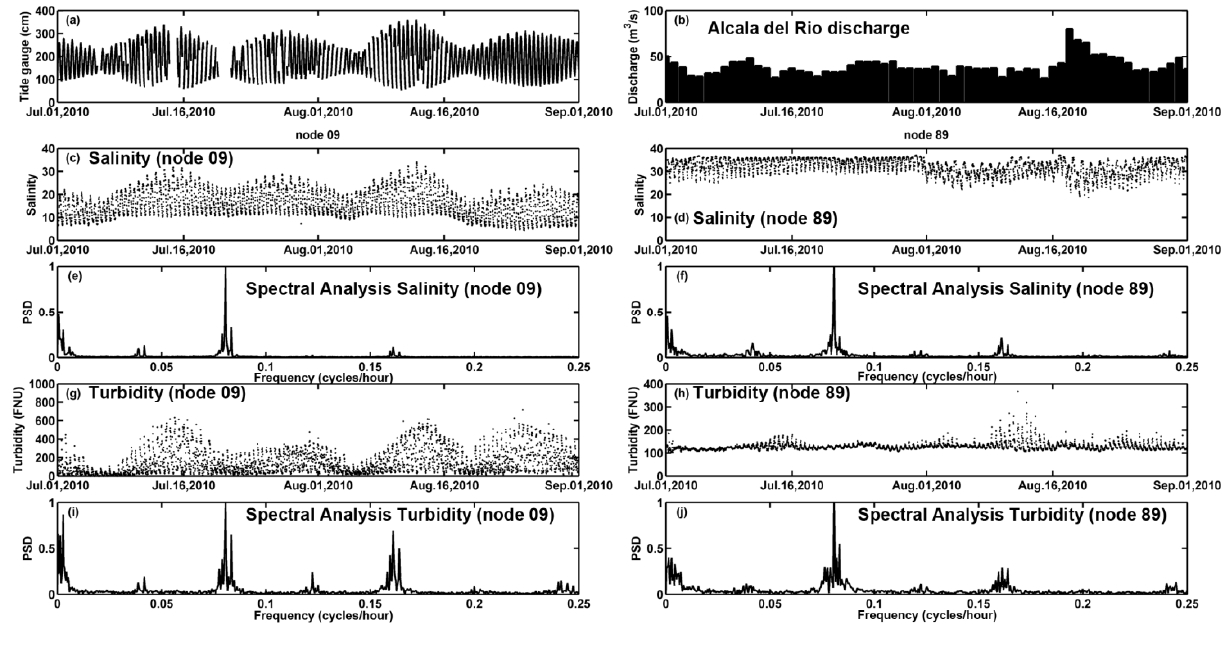
Figure 11. ( a ) Tide gauge; ( b ) Daily average river discharge from the Alcalá del Río dam. Temporal patterns of salinity at node 09 ( c ) and node 89 ( d ). Normalized power spectrum for salinity at node 09 ( e ) and node 89 ( f ). Temporal patterns of turbidity at node 09 ( g ) and node 89 ( h ). Normalized power spectrum for turbidity at node 09 ( i ) and node 89 ( j